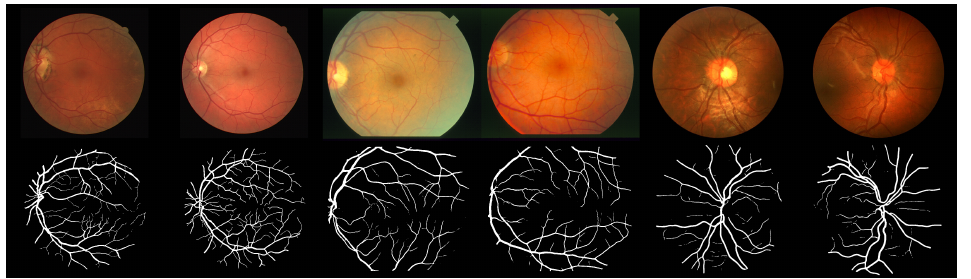
Figure 3. Examples of images used in the study. In the first row are fundus images from DRIVE, STARE, and CHASE datasets. In the second row are the corresponding segmentation